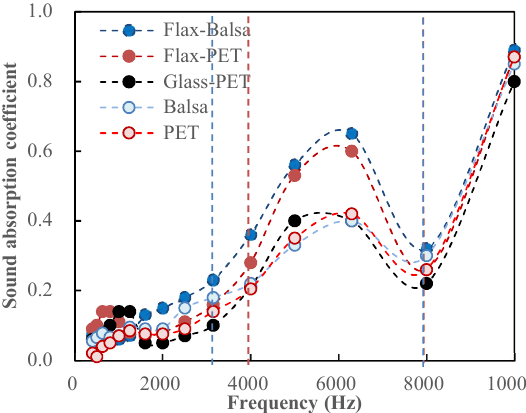
Figure 10. The experimental sound absorption coefficients of sandwich structures and their corresponding core materials.